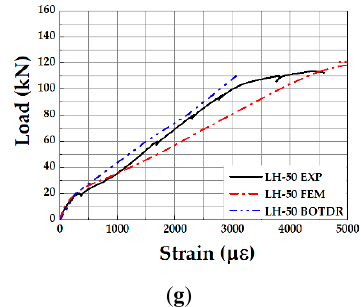
Figure 8. Comparison of load-strain curves between experiment and analysis in the CFRP sheet. ( a ) A-100, ( b ) M-50, ( c ) M-30, ( d ) E-50, ( e ) E-30, ( f ) LE-50, and ( g ) LH-50.